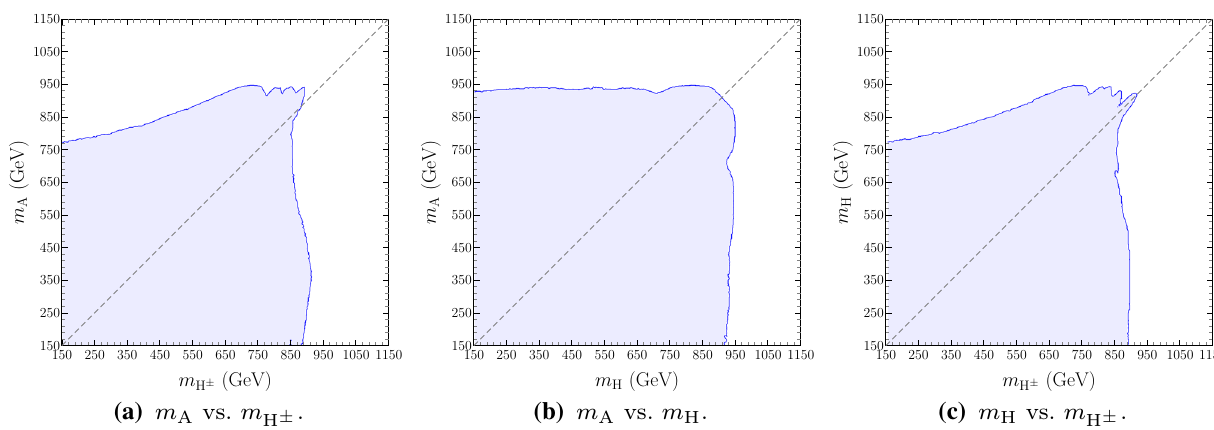
Fig. 4 Regions allowed at 99% CL by the requirements on the scalar sector